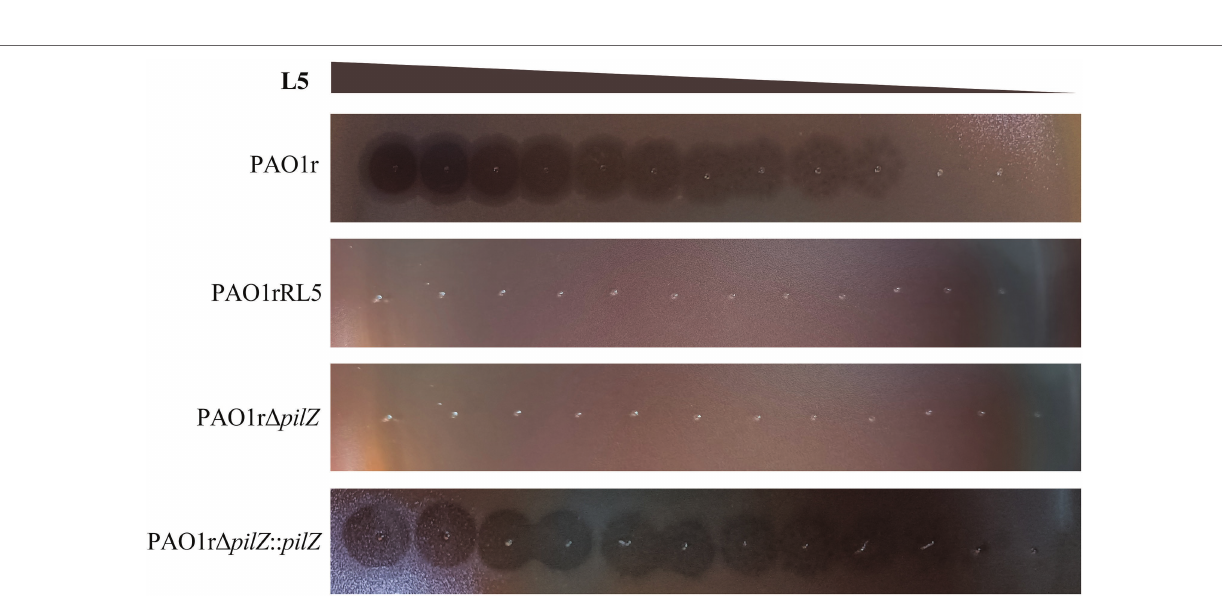
FIGURE 5 | Phage Plaquing Assay of P. aeruginosa phage L5. The strain PAO1r and the strain PAO1r Δ pilZ :: pilZ are susceptible to L5, while the strain PAO1rRL5 and strain PAO1r Δ pilZ are resistant to